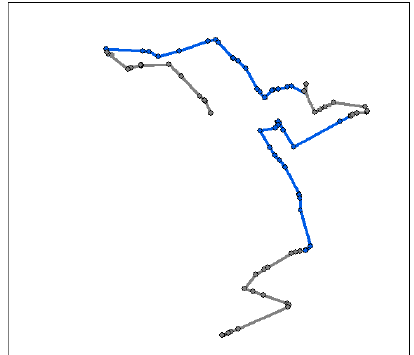
Figure 2. The trajectory of a taxi. The dots indicate the sample points, the blue line indicates that the taxi is occupied and the gray line represents the cruise